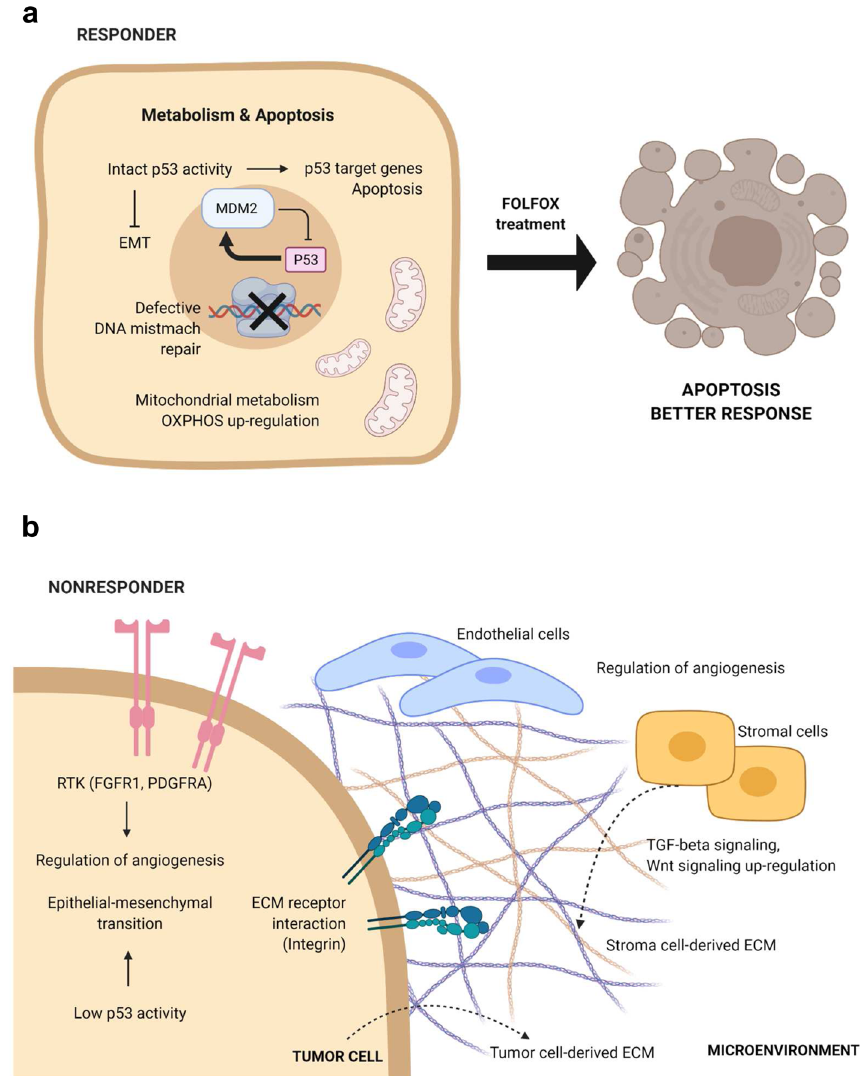
Fig. 6 Summary of integrative characteristics associated with 5-FU-based therapy responding and non-responding tumors. a Representative pathways enriched in the R group. b Representative pathways enriched in the NR group. The fi gures were generated with